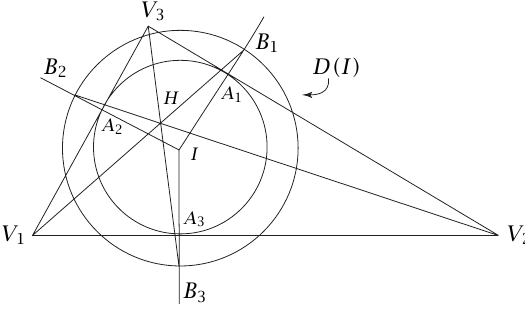
Figure 4 . ∆ V 1 V 2 V 3 and circle D(I)